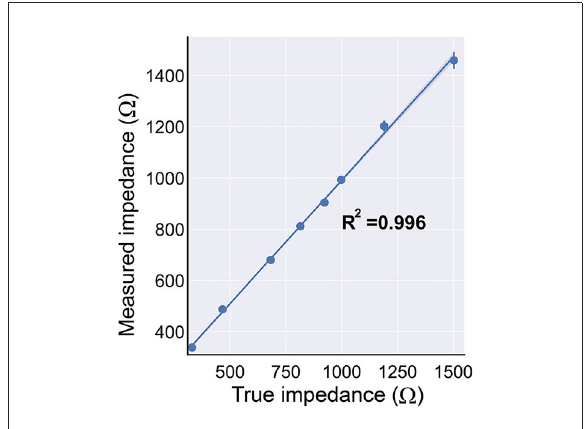
FIGURE10 The BD-BCI on-board impedance measurement. The true impedance vs. the measured impedance demonstrates that the impedance measurement is accurate. The impedance monitoring ensures the electrode’s contact with the brain is sufficient for safe stimulation.